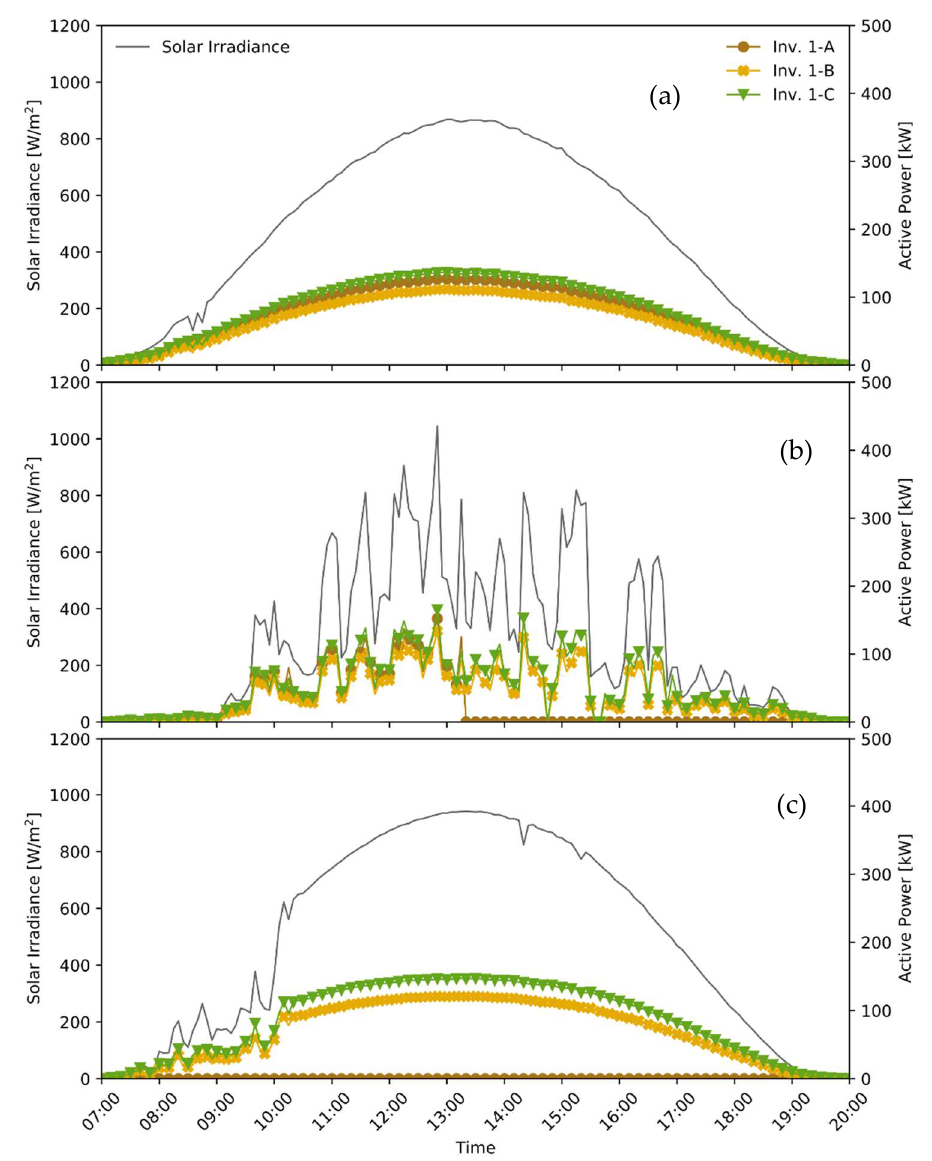
Figure 4. Analysis of sensor signals of the Inverter 1 on 30st August ( a ), on 31th August ( b ) and on 1st September ( c )—Solar Irradiance over the Active Power of the inverter blocks.